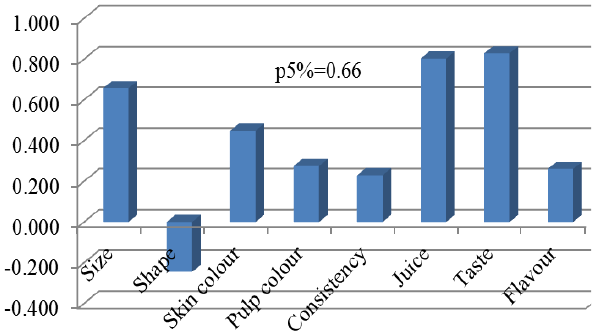
Fig. 4. Correlation among marks for fruit of different apple cultivars, after tasting evaluation using Questionnaires 1 and 2 Table 2. Organoleptic data for fruit quality evaluated with Questionnaire 1 Nr. Cultivar